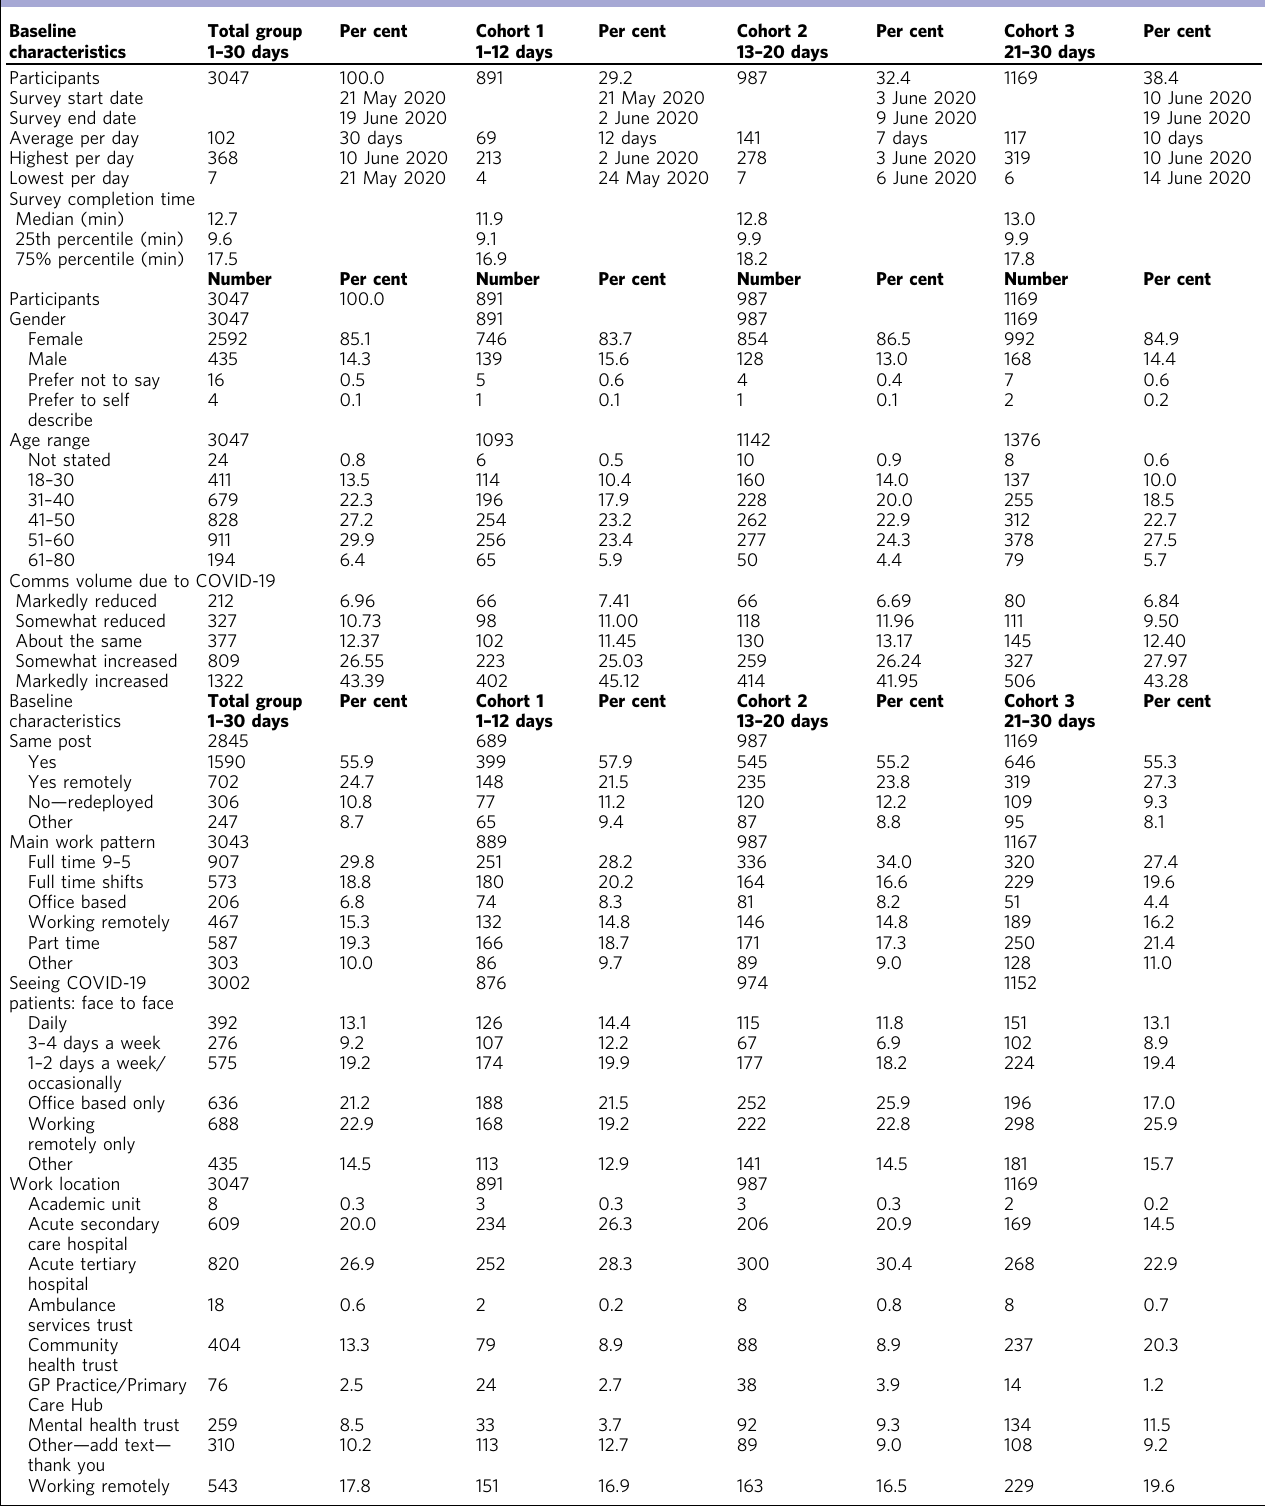
Table 1 Survey Section